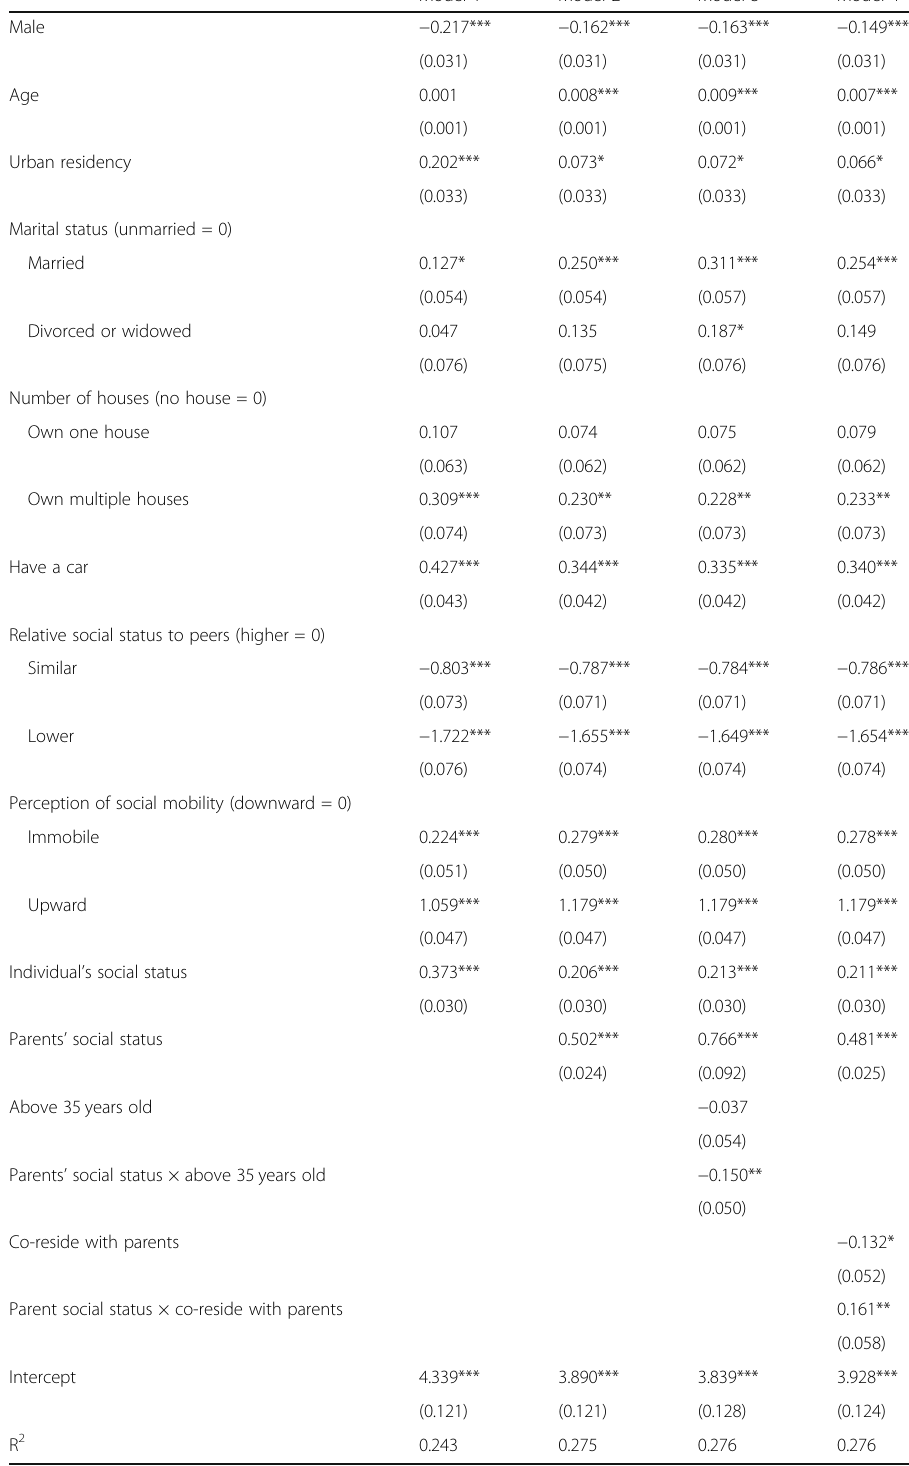
Table 3 The effect of parents ’ social status on children ’ s subjective class identity ( N =